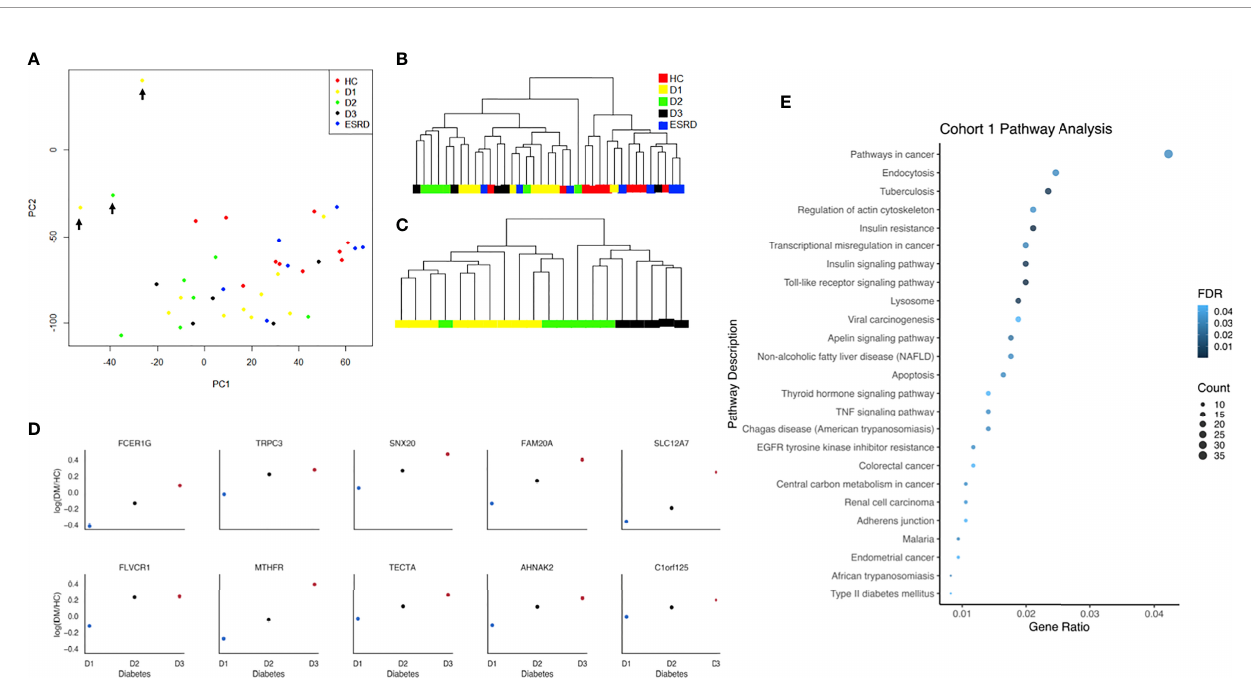
FIGURE 2 | (A) Principal component analysis plot with all samples and unique genes from the microarray analysis performed on peripheral blood mononuclear cells (PBMCs) from patients at different stages of DKDs (Cohort 1). Outliers are marked with black arrows. (B) Dendrogram of unsupervised clustering for all samples of diabetes (D1, D2, D3), ESRD, and healthy controls without the outliers is based on the signi fi cant genes determined by ANOVA (p < 0.05). (C) The dendrogram of unsupervised clustering for samples with diabetes only without the outliers is based on the top 100 signi fi cant genes, whose expression increased with disease severity as determined by the JT test. (D) Facet grid plot of representative genes from cohort 1 with a positive correlation between its expression and degree of albuminuria shown as log fold change compared to control. Candidate genes were selected by taking the top ten statistically signi fi cant genes. The analysis demonstrates the higher expression of FcER1 in more advanced stages of diabetes. (E) Dot-plot showing the top pathways in cohort 1. HC, Healthy control; D1, diabetes with normoalbuminuria; D2, diabetes with microalbuminuria; D3, diabetes with macroalbuminuria; ESRD, end stage renal